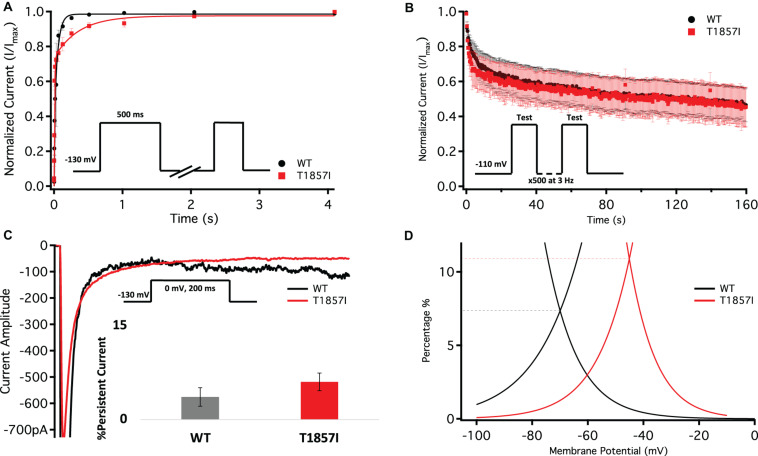
Comparison of Fast Inactivation Recovery, Use-Dependence, Persistent Currents, and Window Currents. (A) Recovery from fast inactivation. (B) Use-dependent inactivation at 3Hz. Show normalized current decay plotted as a function of time. (C) Representative current traces of late currents in WT and T1857I. Average late sodium current as a percentage of peak sodium current. (D) Window currents obtained from the overlap of the GV and SSFI curves shown in Figures 3A,D. The curves shown are the Boltzmann fits of the data. The dashed lines show the approximate window peak, on a Y-axis that is converted to percentage as described in Wang et al. (1996). The peak for WT is reached at −70 mV and 7.4%, and for T1857I at −45 mV and 10.9%. The window area for T1857I is about 62% bigger than WT.